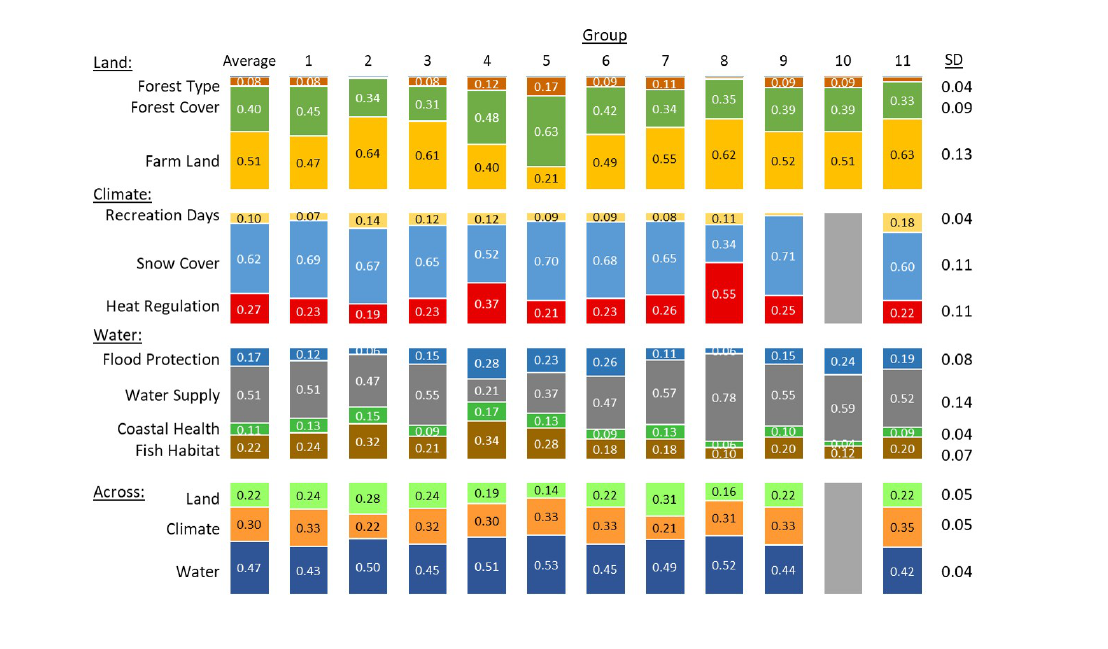
Fig. 2. Trade-off weights in each domain and across domains as estimated from the deliberative valuation workshops and rescaled to account for the range of attribute levels across the eight